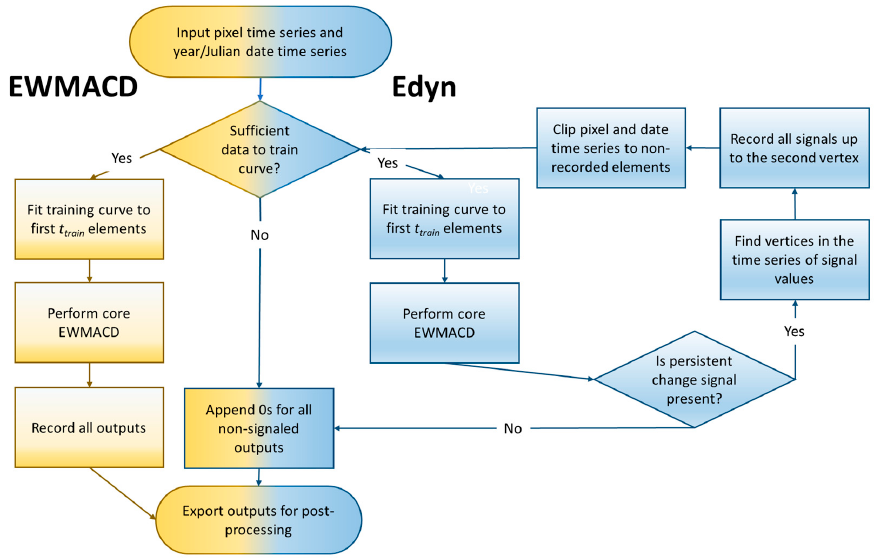
Figure 4. Workflow for EWAMCD and Edyn algorithms. Complete details for core EWMACD processing can be found in Brooks et al., 2014 [5]; a brief description can be found in Section 2.2 and Figure 3.